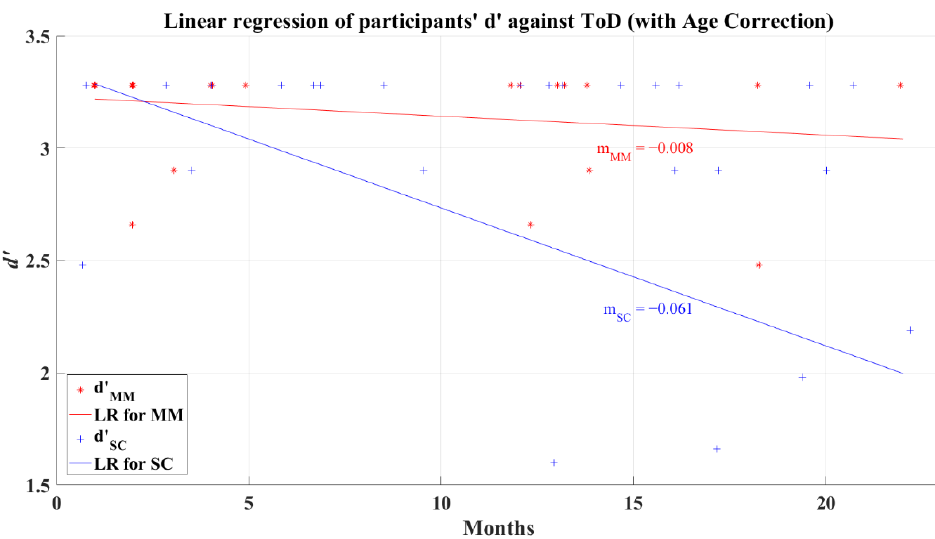
Figure 16. Linear regression of participants’ d’ versus elapsed time of diagnosis with corrected age-effect for 2AFC-P1. Red line—linear regression for Mild-Moderate post-COVID group (LR for MM); blue line—linear regression for Severe-Critical post-COVID group (LR for SC); 𝑑′ (cid:3014)(cid:3014) , Mild-Moderate group’s efficiency index; 𝑑′ (cid:3020)(cid:3004) , Severe-Critical group’s efficiency index; 𝑚 (cid:3014)(cid:3014) , Mild-Moderate group’s slope; 𝑚 (cid:3020)(cid:3004) , Severe-Critical group’s slope.